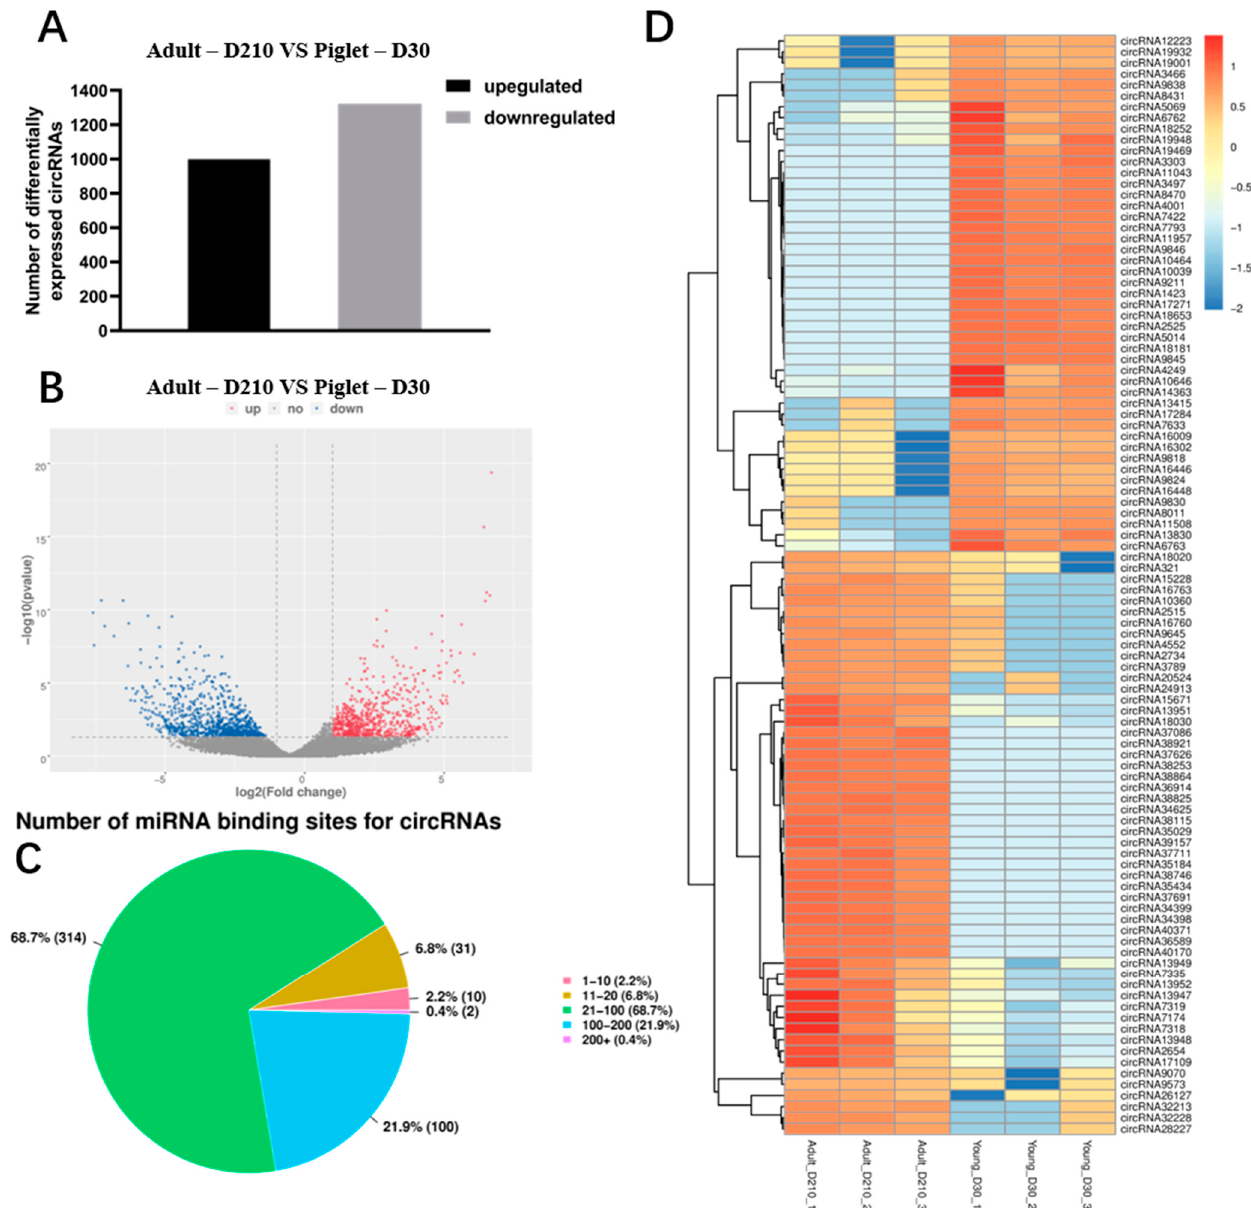
Figure 4. Differentially expressed circRNAs in testes tissues of young (Piglet-D30) and sexually mature (Adult-D210) boars. Significantly differently expressed circRNAs in the testis tissues of young and sexually mature Landrace breeding boars, with upregulated circRNAs on the left and downregulated circRNAs on the right. p Value < 0.05, and log2 (fold change) > 1 or log2 (fold change) < − 1 ( A ). Volcano plot of significantly differently expressed circRNA, where red represents the upregulated circRNAs and blue represents the downregulated circRNAs ( B ). Analysis of the proportion of circRNA processing different numbers of miRNA targets ( C ). Heat map showing the changes of the first 100 significantly differently expressed circRNAs in the testis tissues of young and sexually mature Landrace breeding boars. Red represents upregulation and blue represents downregulation ( D ).